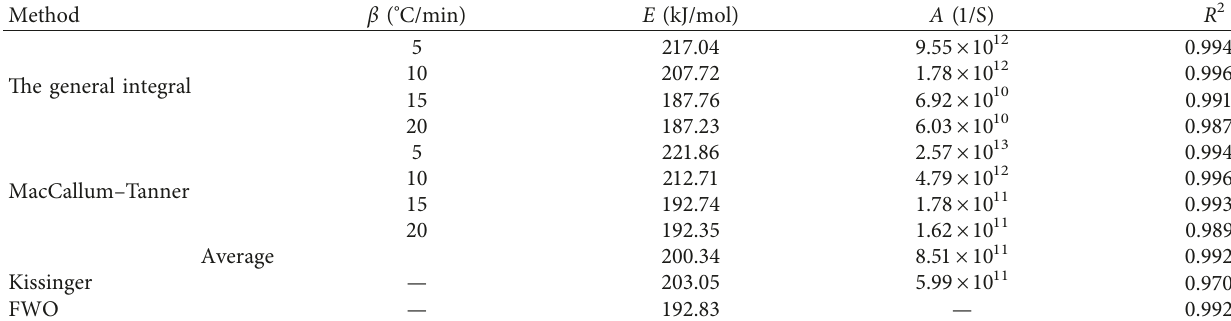
Table 4: Calculation results of coal WJG.